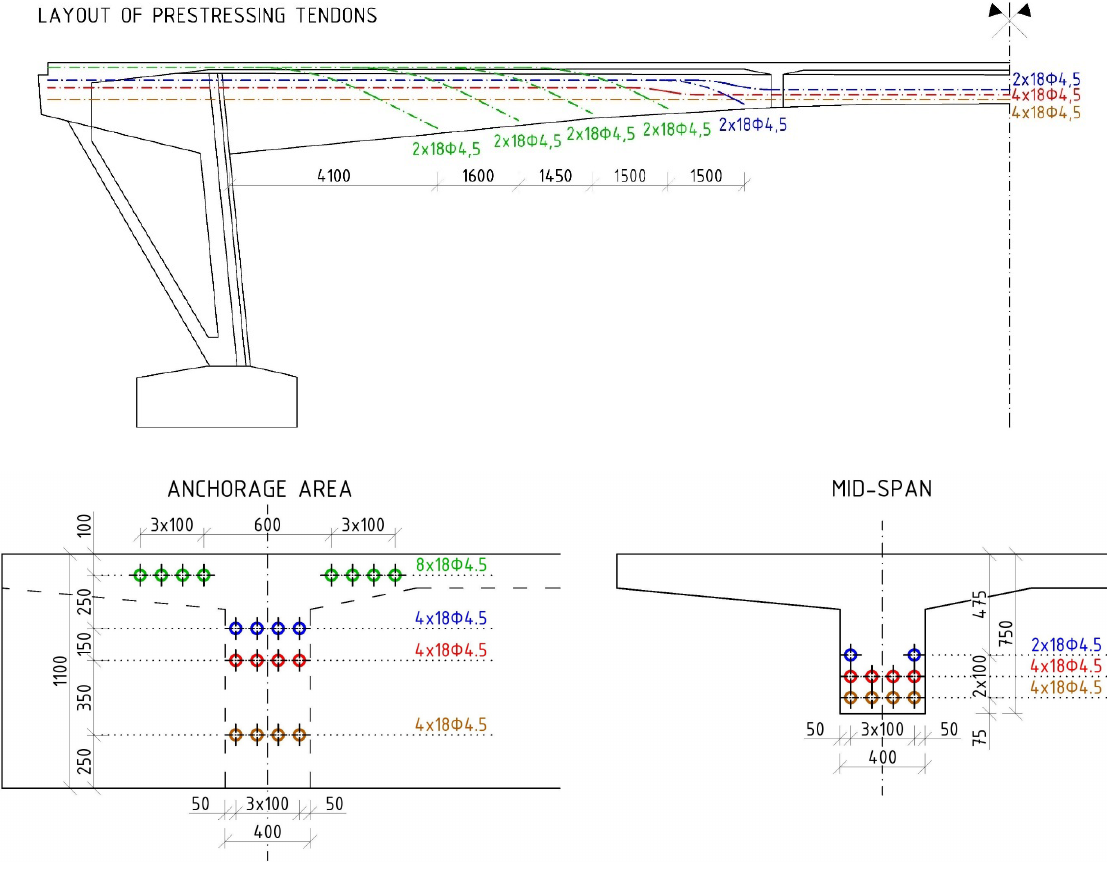
Figure 6. The layout of prestressing tendons (dimensions are in [mm]).